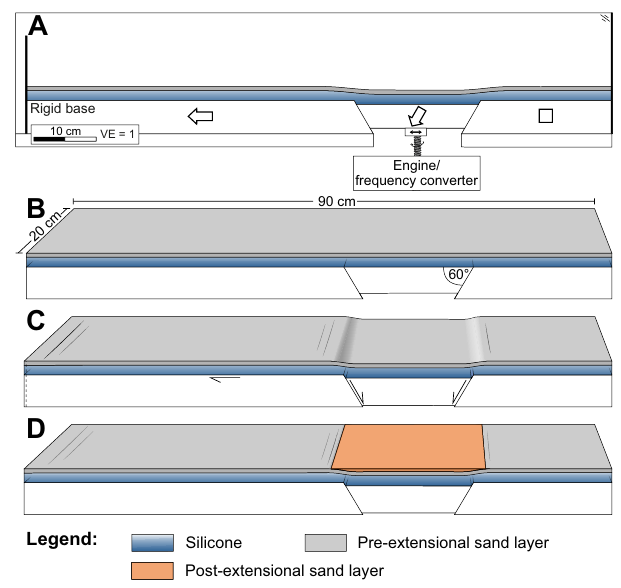
Figure 2. (a) Side view of experimental box comprising analogue materials silicone and granulate as well as subdivided rigid base- ment. Basal displacement is driven by a controlled engine. (b) In general the model procedure starts with a planar layer configura- tion. (c) Basal displacement is applied. (d) Surface depressions are filled with sifted granulate. Sieving procedure is repeated